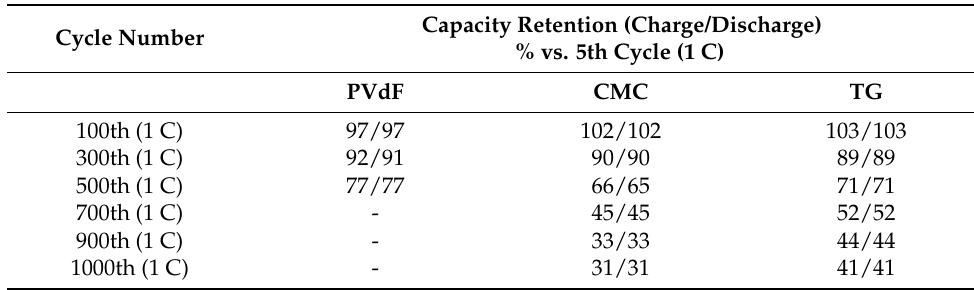
Table 4. Summary of capacity-retention percentiles of LNMO electrodes with different binders. Cycle